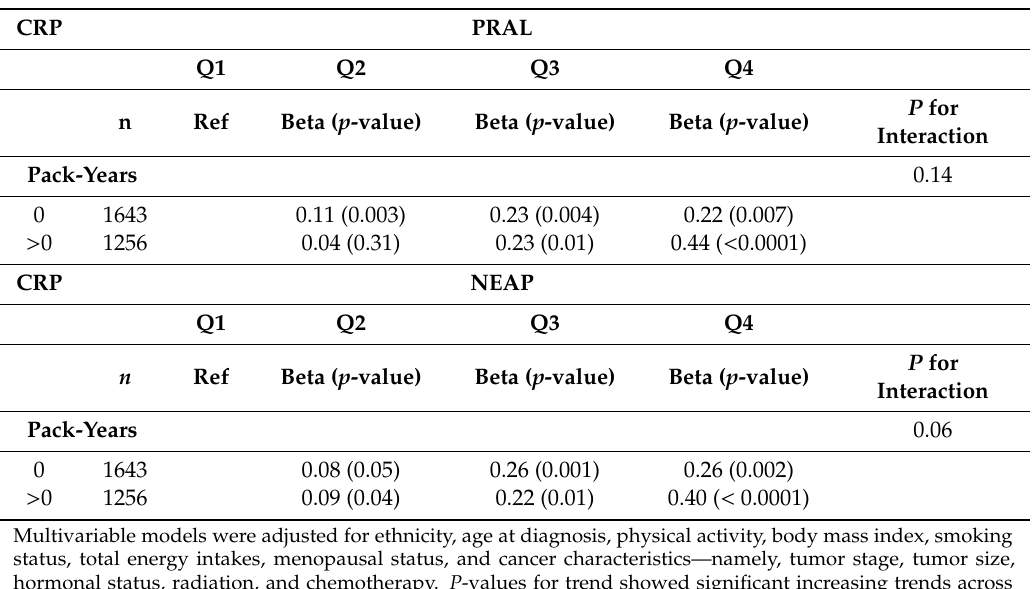
Table 4. Multivariable-adjusted associations between dietary acid load (PRAL and NEAP) and CRP, stratified by pack-years of